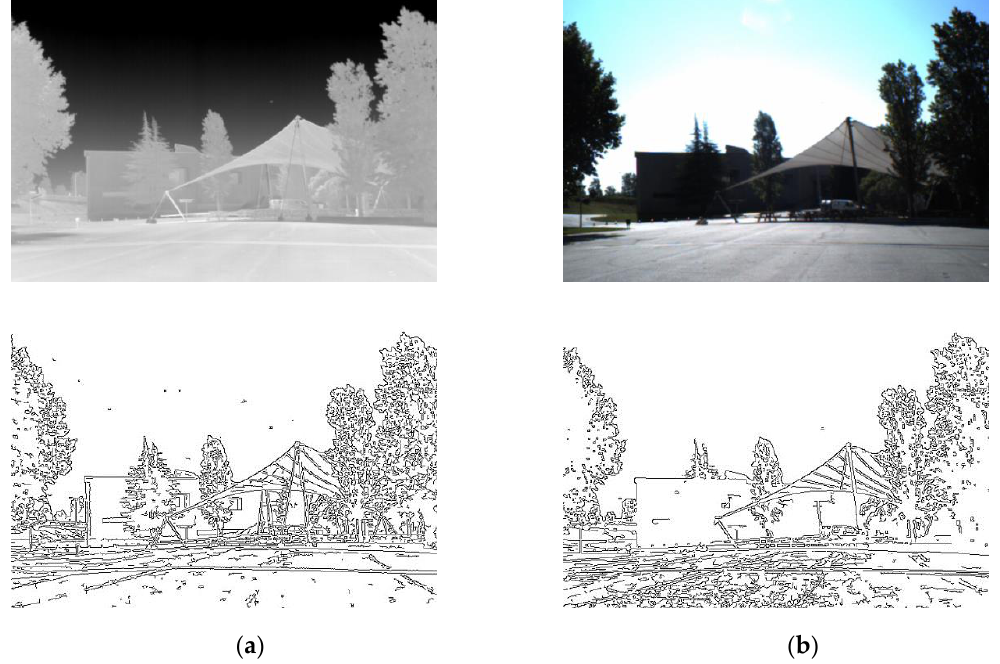
Figure 1. Edge images extracted from infrared and visible images. ( a ) Infrared image and the corresponding edge image. ( b ) Visible Image and the corresponding edge image.